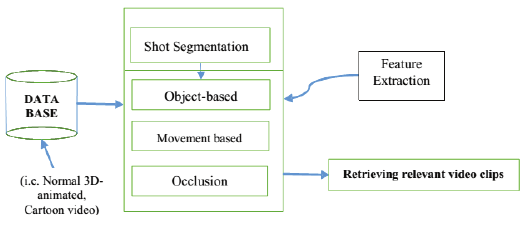
Fig. 1. Proposed method of CBVR